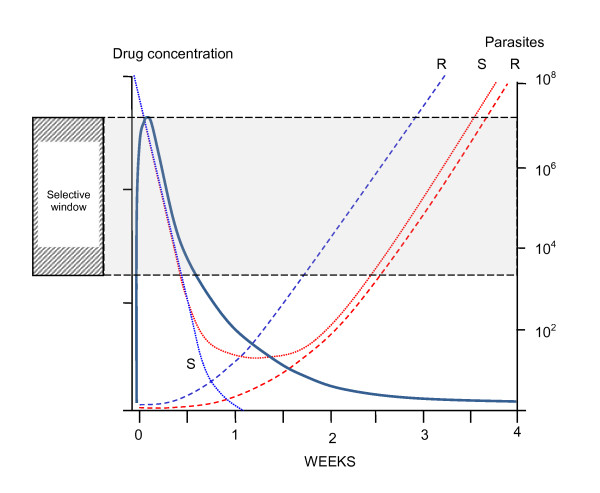
The anti-malarial concentration window of selection [18]. The drug concentrations (solid lines) following two doses which define the concentration limits of the window of selection are shown for patients with low parasitaemias (108/body). Total parasites within the body are depicted by dotted and dashed lines. The window opens when following the higher dose (blue) sensitive parasites (blue dotted line) are eliminated but de-novo resistant parasites (blue dashed line) can survive, and successful selection of resistance can take place. Following the lower dose the sensitive parasites can still survive (red dotted line) and later grow to outnumber the drug resistant parasites (blue dashed line) by >9:1, so there is no longer an opportunity for preferential survival of the resistant parasites and thus selection. The window closes. Concentrations between these two boundaries (the "window of selection") are selective.